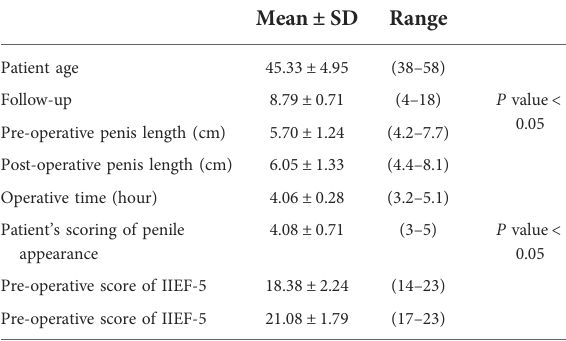
TABLE 2 Clinical data of the 24 included